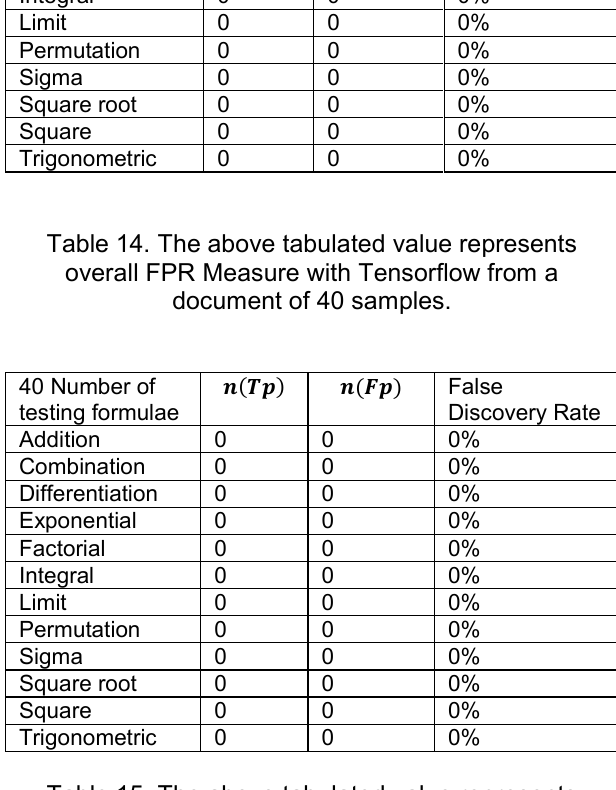
Table 15. The above tabulated value represents overall FPR Measure with Tensorflow from a document of 60